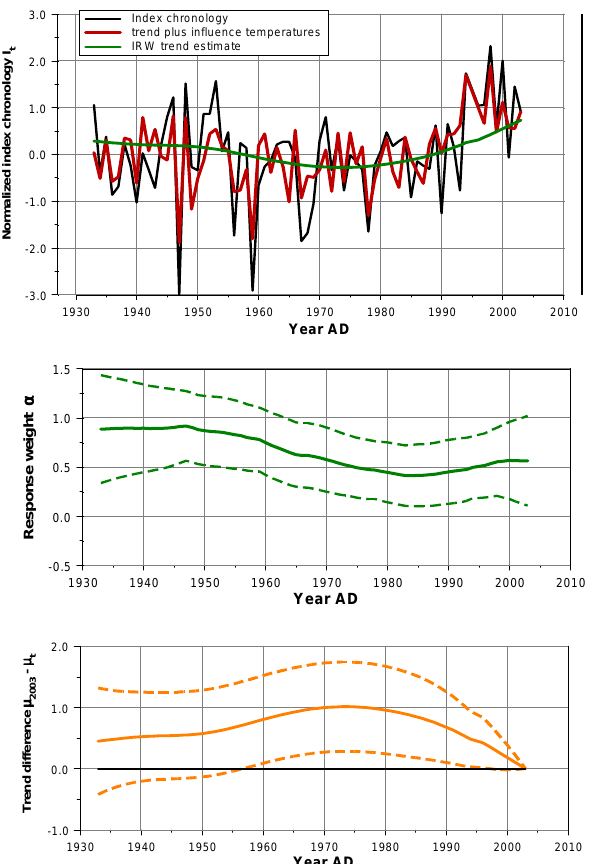
Fig. 1. SRF estimates for the MXD chronology derived at Coppermine. Period: 1933-2003. The black line in the upper panel represents the normalized indices, the green line the estimated IRW trend and the red line the trend plus influence of July-August temperatures. The response ˆ α appears to be time varying (middle panel, with 95% confidence limits). The trend differences with 95% confidence limits are shown in the lower panel.